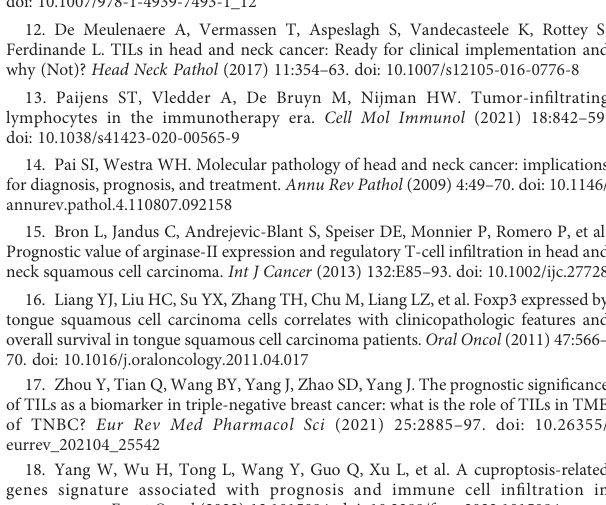
SUPPLEMENTARY FIGURE 2 Survivaldifferencesbetweenthetworiskgroupsinsubgroupsofotherclinical indicators. (A, B) : gender group; (C, D) : metastatic group. SUPPLEMENTARY FIGURE 3 The distribution of risk score (A) and survival status (B) . SUPPLEMENTARY FIGURE 4 (A, B) TILscore and tumor metastasis are independent prognostic factors. (C, D) Nomogram for predicting survival status of OS patients at the 1st, 3rd and 5th year. SUPPLEMENTARY FIGURE 5 Visualization of differences in microenvironment scores across risk groups. (A) Heat map showing the difference between the 4 microenvironment scores in the high and low risk groups. (B) Box plots of differences in basal scores, immune scores, and ESTIMATE scores across risk